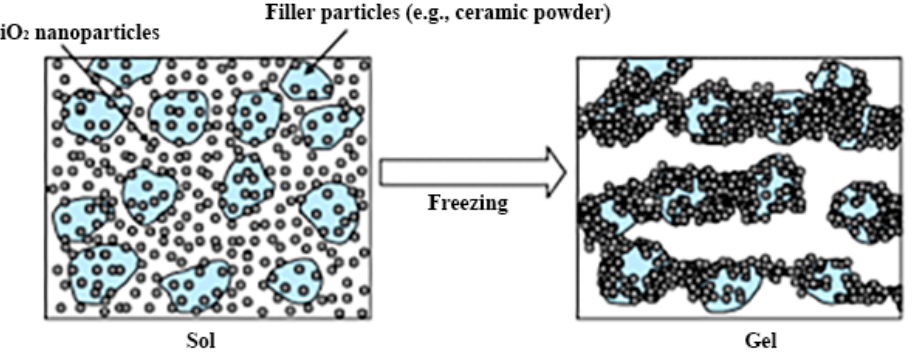
Figure 2. A schematic representation of the colloidal SiO 2 nanosol dispersion irreversible transfor- mation by the sol–gel transition caused by freezing. Reprinted with permission from [21].